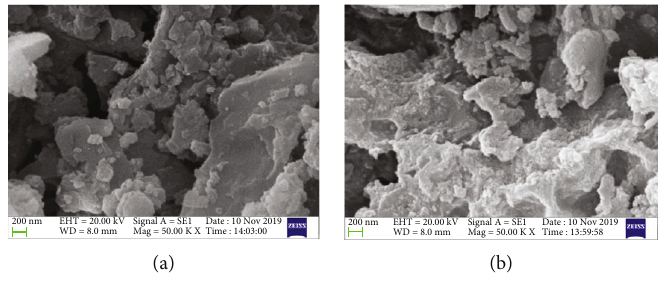
Figure 3: SEM image of biochar: (a) SBC and (b) SP-SBC.